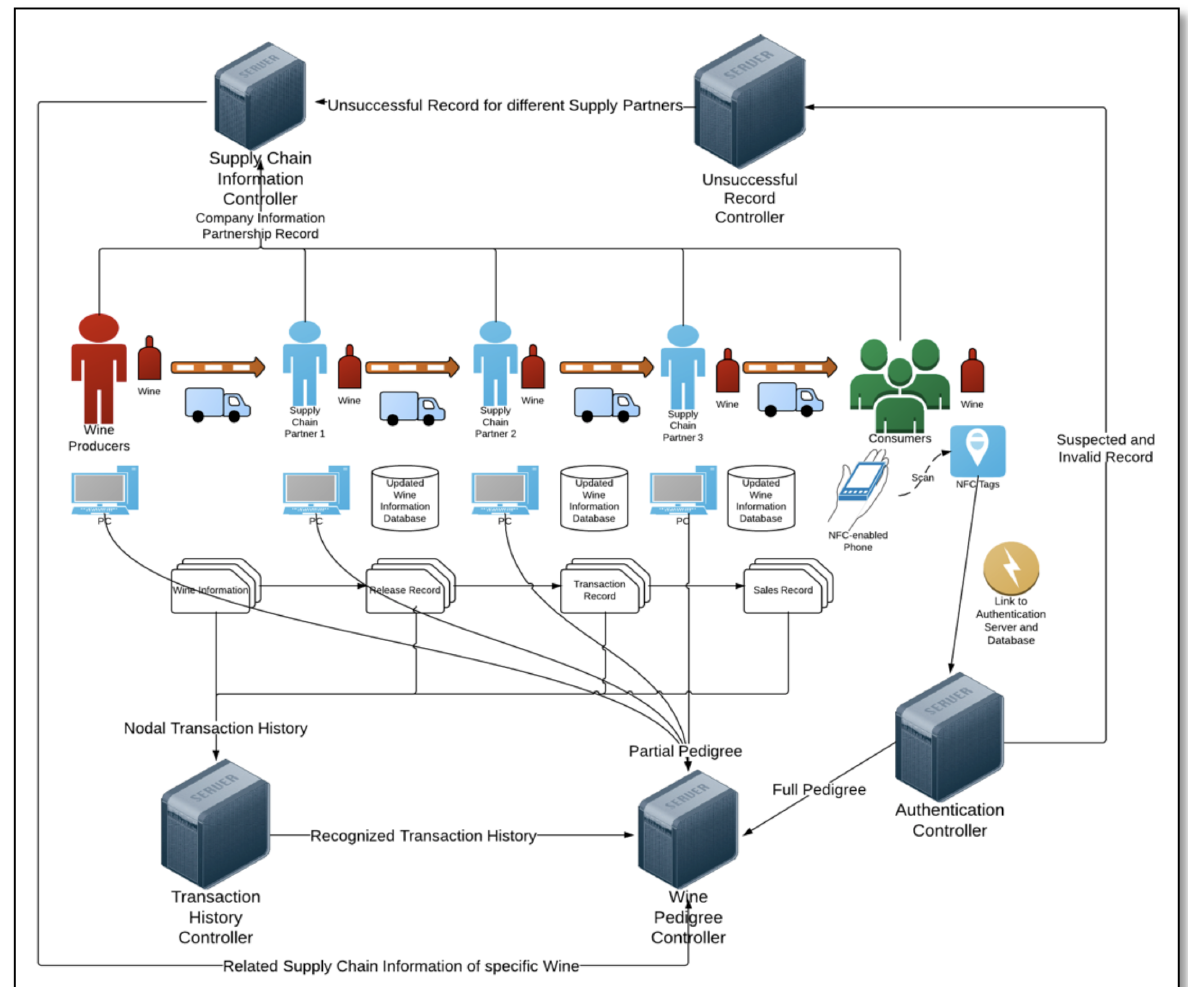
Figure 7. The System Architecture of NFC-Enabled Anti-Counterfeiting System (NAS). Source: Neo C. K.